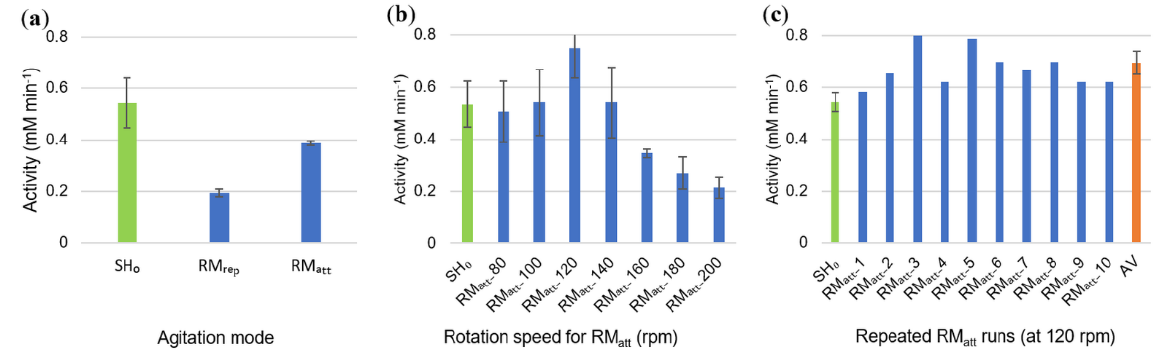
Figure 6. Investigation of the rotating agitation mode with AAL-MNPs. ( a ) Dependence of the effective enzyme activity on permanent magnet configuration (RM att : attraction configuration, RM rep : repulsion configuration; at 150 rpm) compared to shaking mode with fresh AAL-MNPs (SH 0 ). ( b ) Dependence of the effective enzyme activity on the frequency of rotation around the y -axis of the vial (using the RM att mode, in rotation per minute (rpm), within the 80–200 rpm range). ( c ) Investigation of operational stability (repeatability) of the AAL-MNP reaction by RM rep mode at 120 rpm (the biocatalyst was used 10 times after recovery by magnetic decantation). The results and their average (AV) are compared to shaking mode with fresh AAL-MNPs (SH 0 ).